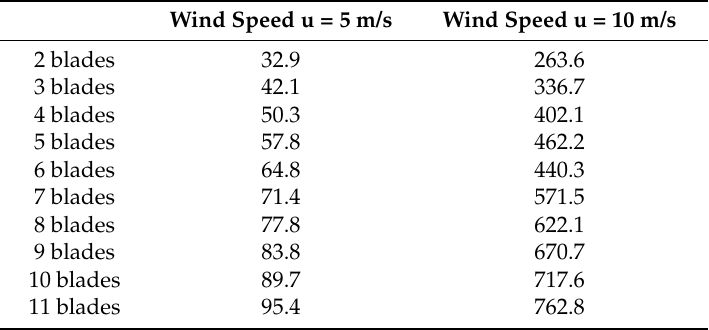
Figure 4. Total power at each blade’s position for wind velocity ( a ) 5 m/s; ( b ) 10 m/s for various numbers of blades. Table 1. Mean power output in Watts for wind speed of 5 m/s and 10 m/s for various numbers of blades.